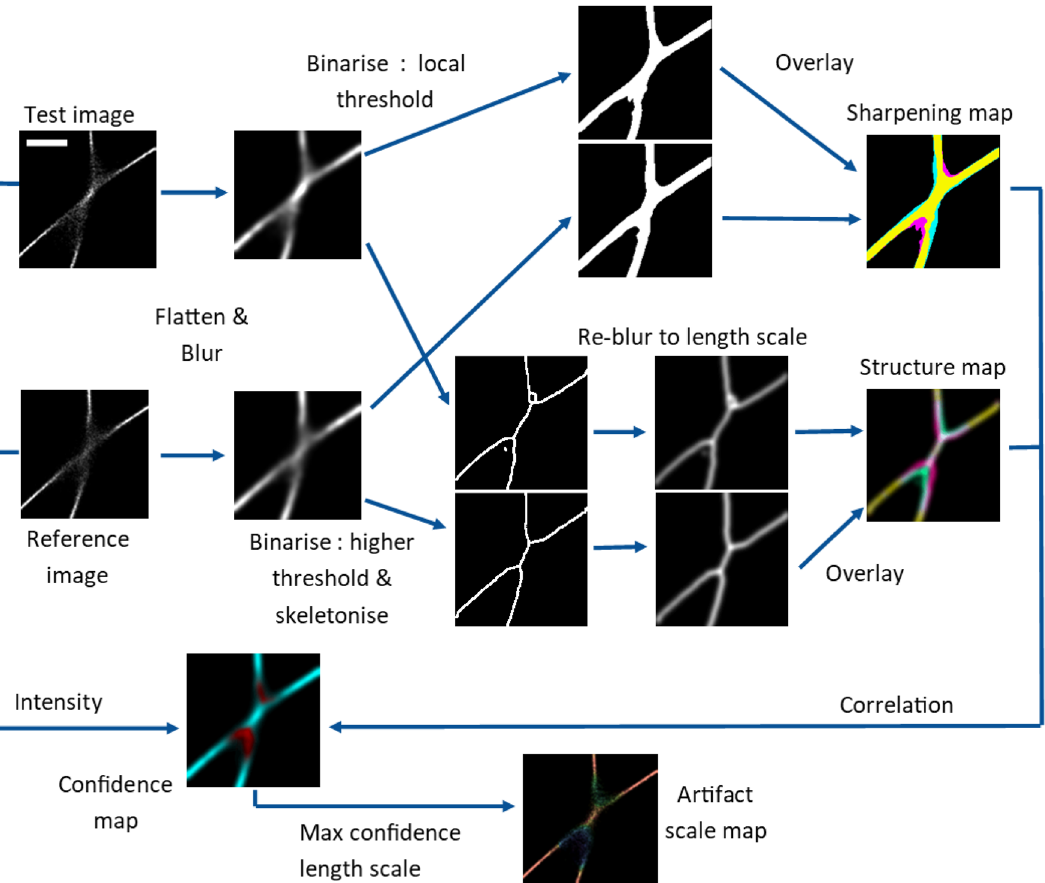
Fig. 1 HAWKMAN method and results on experimental data from the Localisation Microscopy Challenge. The processing steps of the HAWKMAN algorithm, producing the sharpening map, structure map and con fi dence map. For the sharpening and structure maps areas of input image agreement are displayed in yellow whereas magenta and cyan indicate structure only present in the test and reference images, respectively. Therefore, magenta indicates arti fi cial sharpening and cyan indicates missing structure. The con fi dence map indicates the calculated local correlation score (see Methods for details), ranging from 0 (red) to 1 (cyan), whilst brightness denotes the intensity of the original images Repeating the process at many length scales can indicate how the size of artefacts varies over the structure as indicated in the artefact scale map. Scale bar 500